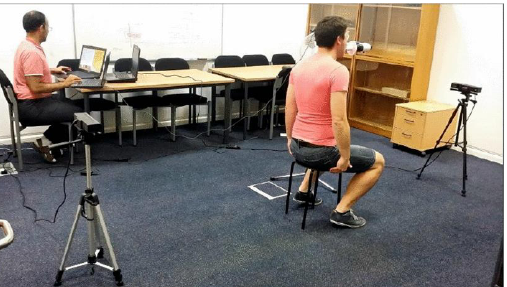
Figure 3. Measurement setup with two Kinect v2 cameras facing each other. The subject sits on a chair without a backrest and breathes through a reference spirometer. The image is taken from